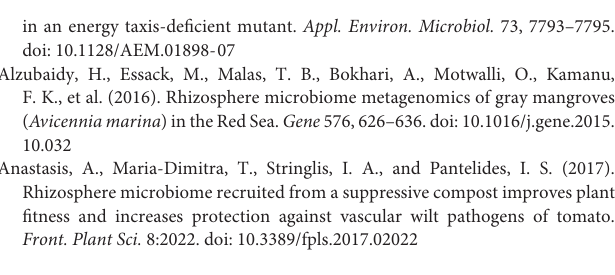
Supplementary Figure 1 | Divergent responses of different genera as indicated by the log2 of ratio on the number of enriched (NEG) to diminished genes (NDG) were largely associated with the changes in gene abundance of each